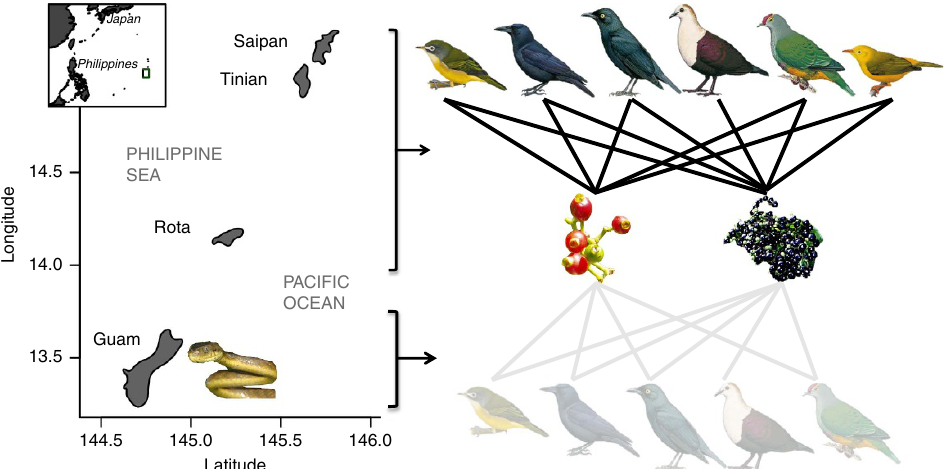
Figure 1 | Study site. Guam, the southernmost island in the Mariana Islands, is home to the invasive brown treesnake and thus virtually all forested lands are bird-free, whereas the nearby islands of Saipan, Tinian and Rota are snake-free, and have relatively healthy bird communities. On islands with birds, the primary frugivores (from left to right) for two tree species whose fruits are depicted in the middle, Psychotria mariana (left) and Premna serratifolia ( right), include the bridled white-eye ( Zosterops conspicillatus ), and Rota bridled white-eye ( Zosterops rotensis ; both Zosterops species represented by the bridled white eye in the figure), Mariana crow ( Corvus kubaryi ), Micronesian starling ( Aplonis opaca ), white-throated ground dove ( Gallicolumba xanthonura ; Premna only), Mariana fruit dove ( Ptilinopus roseicapilla ) and golden white-eye ( Cleptornis marchei ). As a result of the snake, Psychotria mariana and Premna serratifolia on Guam have functionally lost all of their seed dispersing partners (note that the Rota bridled white-eye and the golden white-eye were not on Guam before the snake introduction). Latitude and longitude are in degrees north and east, respectively. Snake photograph and bird illustrations 54–59 used with